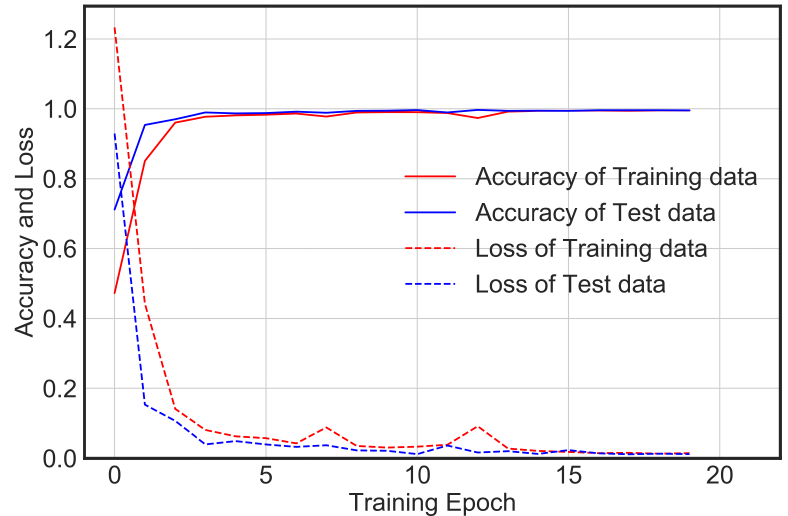
Figure 11. Alex Net model accuracy and loss for augmented dataset.